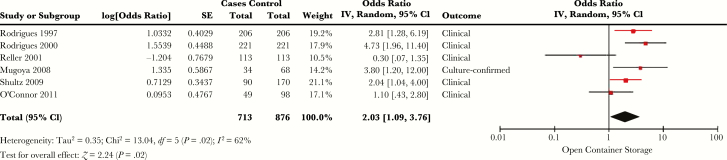
Forest plot of studies included in meta-analysis assessing whether water storage with an open container or bucket was associated with symptomatic cholera. The summary odds ratio was calculated using random effects models. Heterogeneity is described using the Cochran Q test and the I2 statistic. Abbreviations: CI, confidence interval; df, degrees of freedom; IV, inverse variance; SE, standard error.